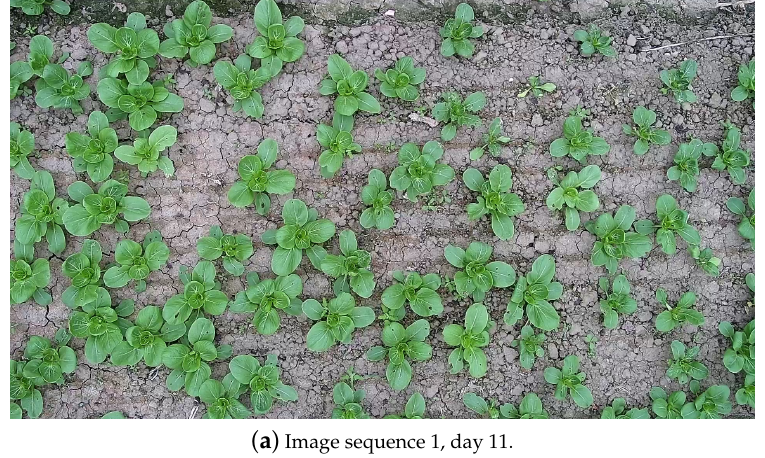
Figure 7. The mean top-view projected area of image sequence 1 varies with date. The solid line is the prediction result of the model, and the dotted line is the annotation result. Only the vegetables in which the top-view projection all appeared in the image were included in the statistics.